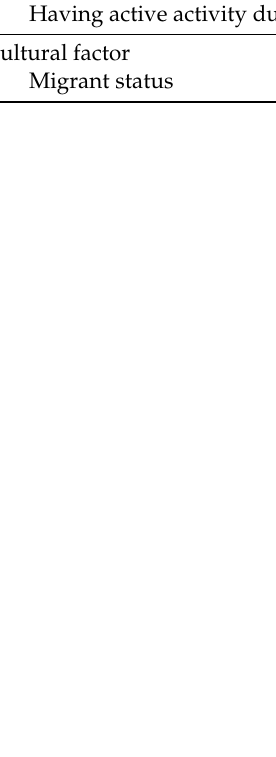
Table 5. Independent predictors of ambulance utilization during the cardiac